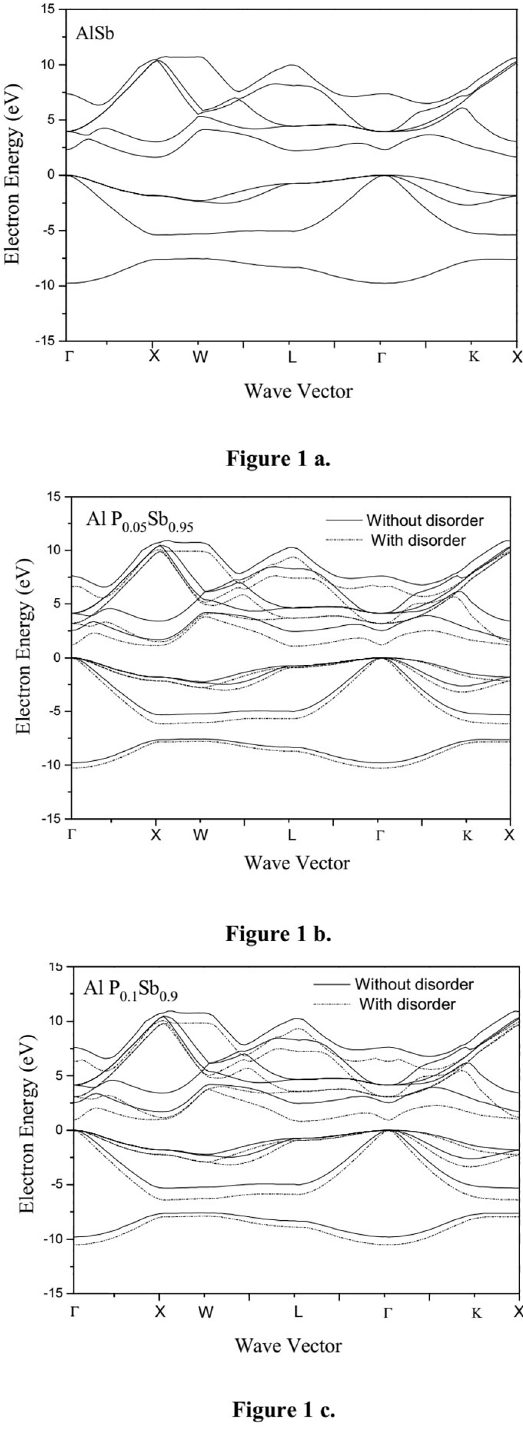
Figure 2. (a) . Direct (Γ-Γ) band gap energy in AlP alloys versus P content calculated with and without considering the compositional disorder effect. (b) . Indirect (Γ-Χ) band gap energy in AlP Sb ternary alloys versus P content calculated with and x 1-x without considering the compositional disorder